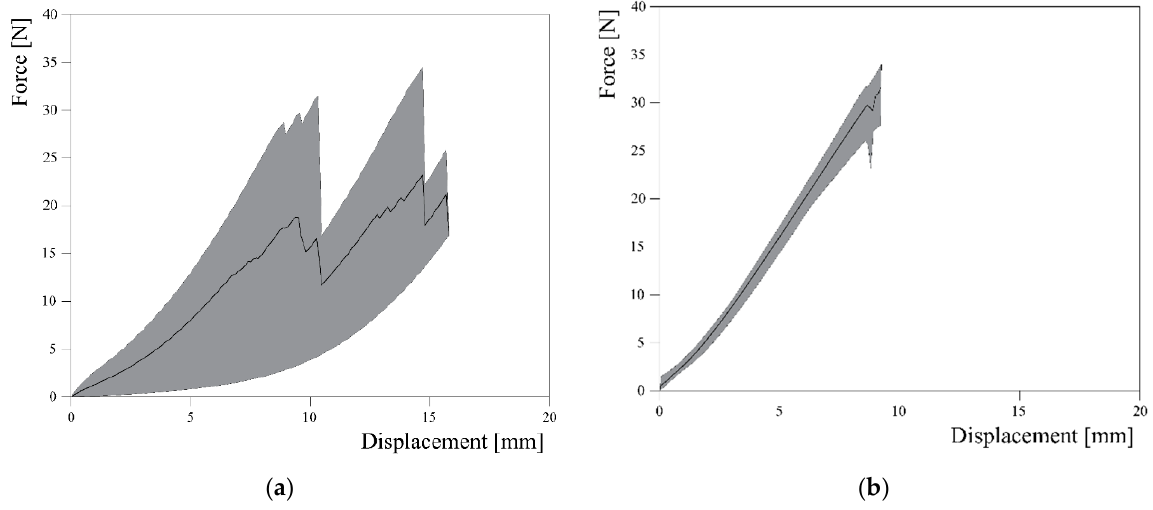
Figure 9. Envelope area between maxima and minima for the Jute yarn ( a ) and Flax yarn ( b ).